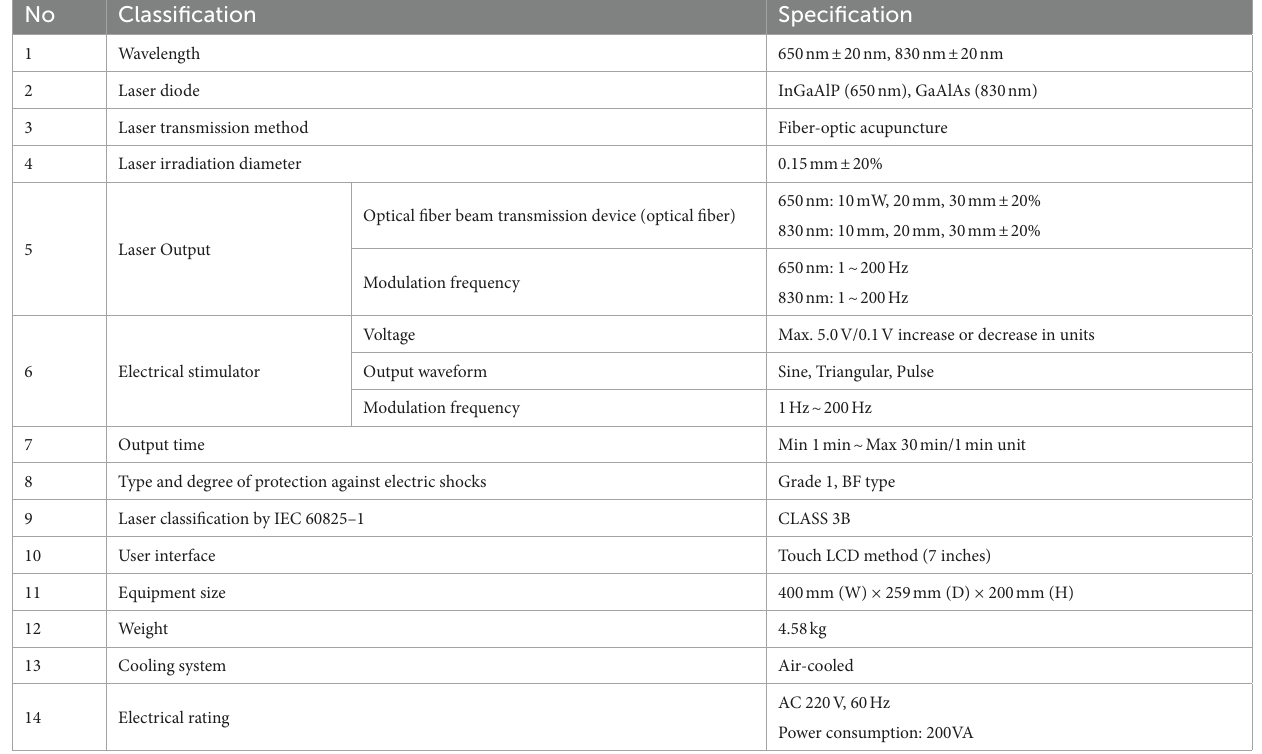
TABLE 2 Specifications of the laser and electrical stimulator system. No